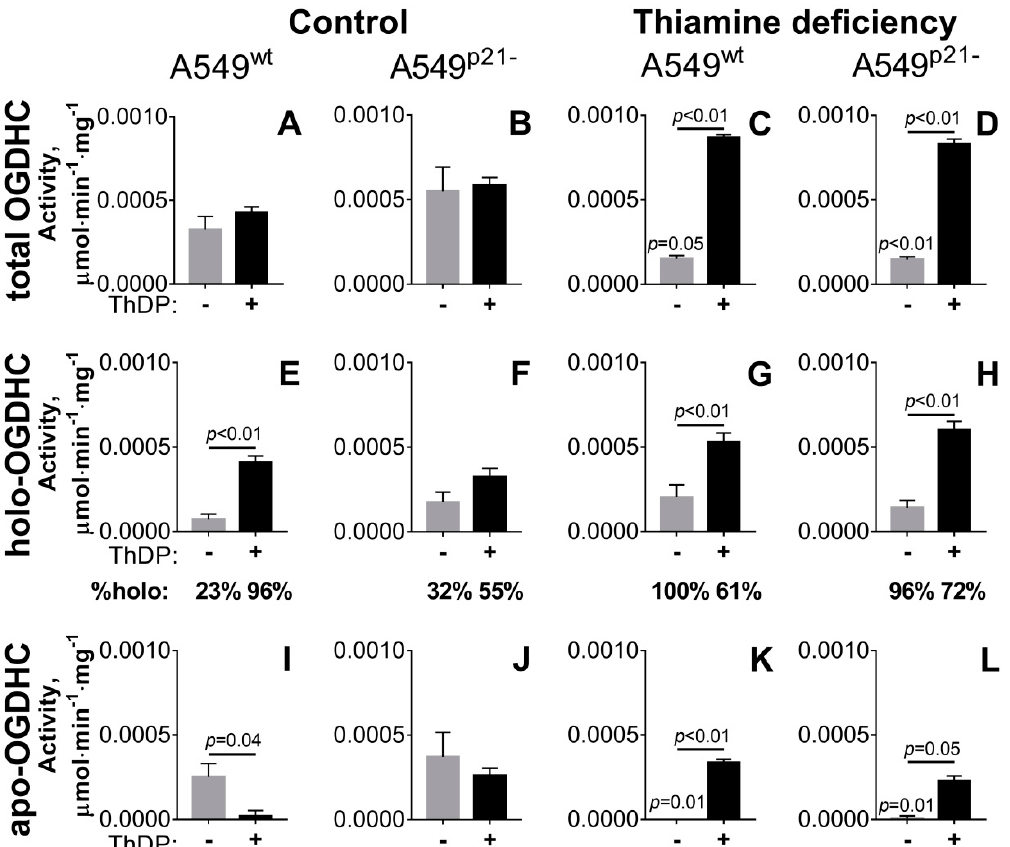
Figure 1. p21-Dependent changes in the total activity of OGDHC ( A – D ) and its partition into the holo- ( E , F ) and apoenzymes ( I – L ) at the exposure of A549 cells to varied thiamine / ThDP levels. A549 wt or A549 p21- cells were cultured in DMEM prepared either with 4 mg / L thiamine hydrochloride (Control, A , B , E , F , I , J ) or without thiamine (Thiamine deficiency, C , D , G , H , K , L ). Analysis was made 24 h after the media were exchanged for those without (gray columns) or with 5 mM ThDP (black columns). The OGDHC partition into the apo- and holoenzymes was determined as described in the text and Materials and Methods. Under the graphs E-H the OGDHC holoenzyme activities are shown as % of total OGDHC activities (“%holo”). The data of at least three independent experiments are presented as mean ± SEM. Statistical significance of the di ff erences between all the groups (shown in full in Table 1) was determined by two-way ANOVA followed by Tukey’s post hoc test. On the graphs, only the di ff erences due to the ThDP / thiamine variations are indicated. The p -values above the horizontal lines or the grey bars characterize the changes due to the ThDP addition or thiamine deficiency,